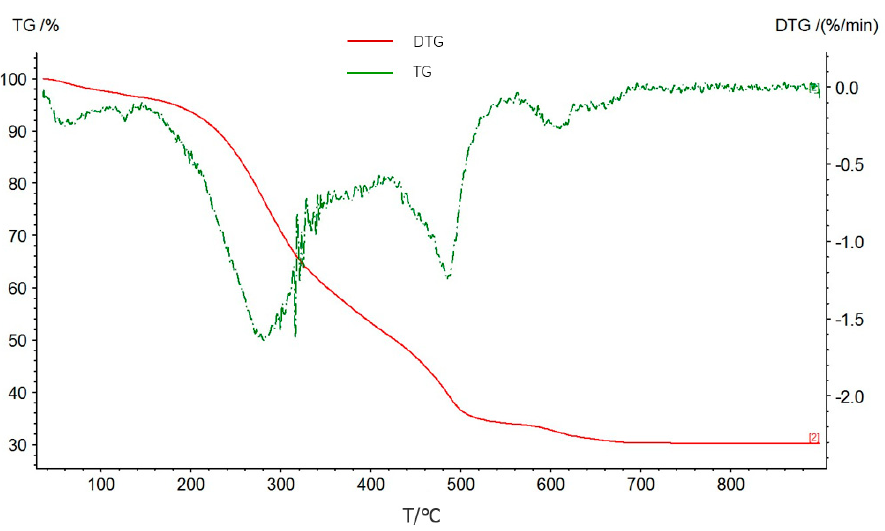
Figure 2. The TG and DTG curves of the chicken manure at a heating rate of 5 °C/min in the presence of air of air atmosphere.